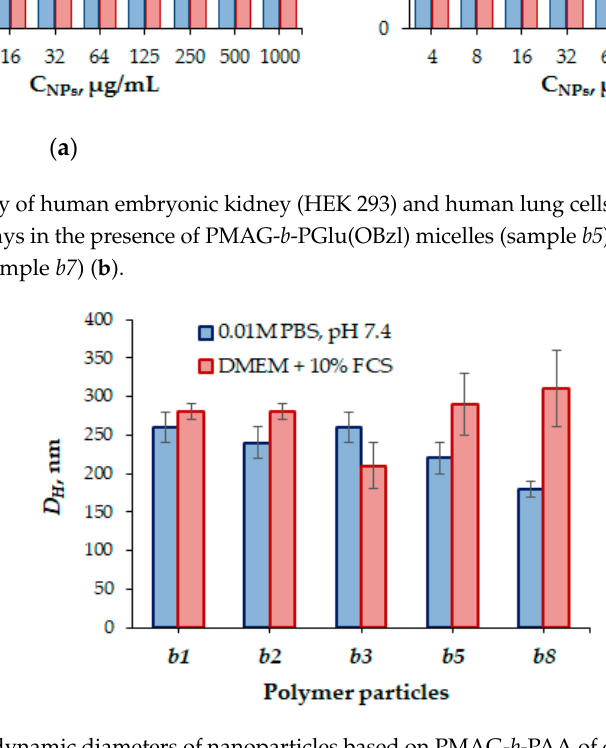
Figure 12. Hydrodynamic diameters of nanoparticles based on PMAG- b -PAA of different compositions in the buffer (0.01 M PBS, pH 7.4) and culture (DMEM + 10% FCS) media.